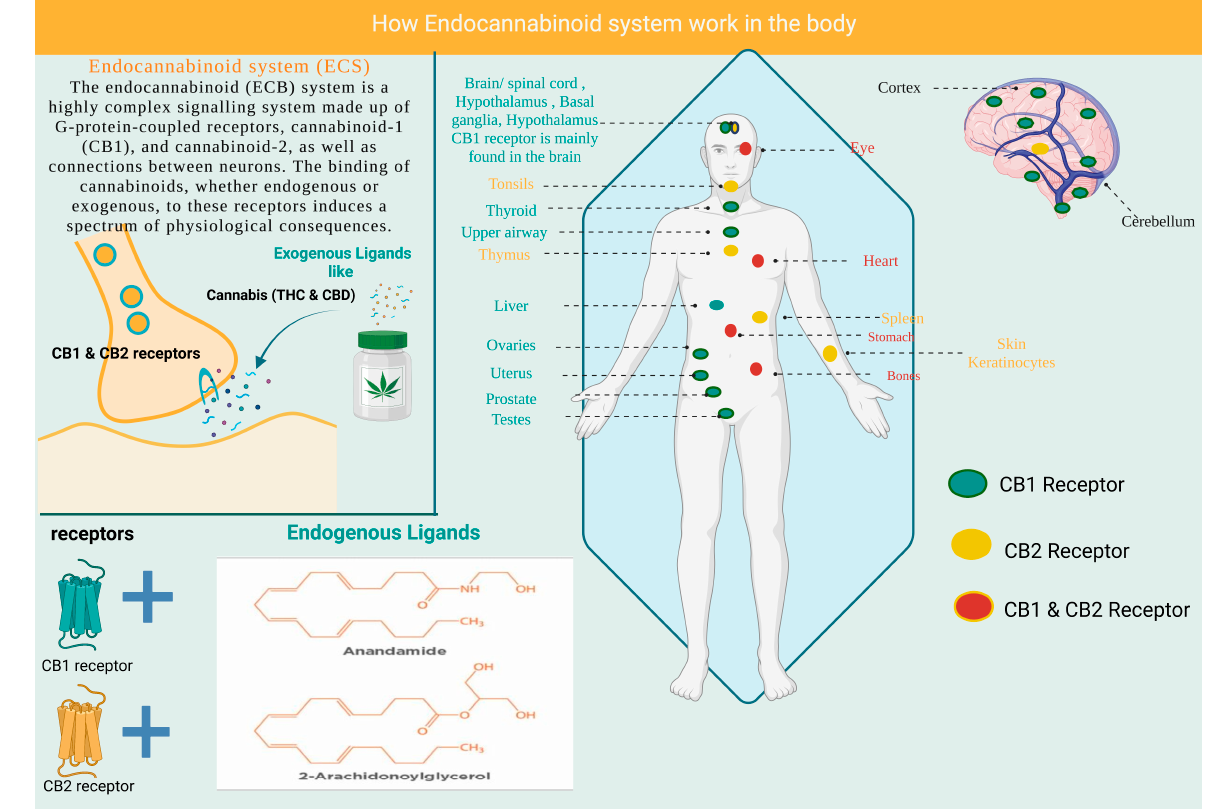
Figure 1. Illustration of the endocannabinoid system and distribution of CB1 receptors. CB1: cannabinoid-1 receptor, CB2: cannabinoid-2 receptor, THC: tetrahydrocannabinol, CBD: cannabinoid.